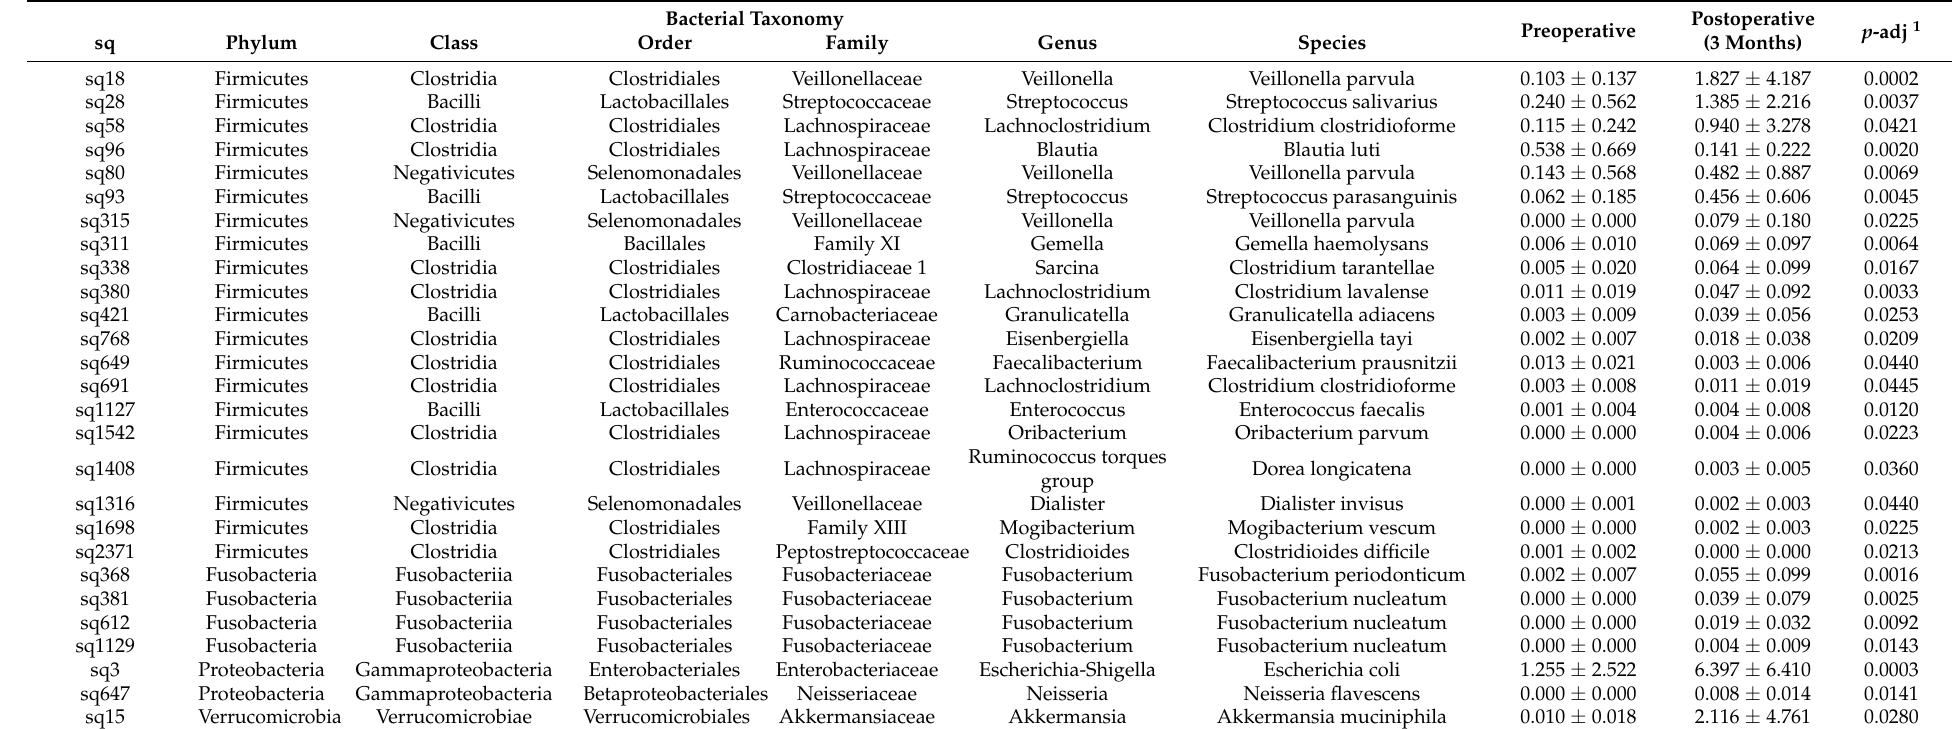
Table 4. Relative abundance (%) of gut bacteria species before and three months after